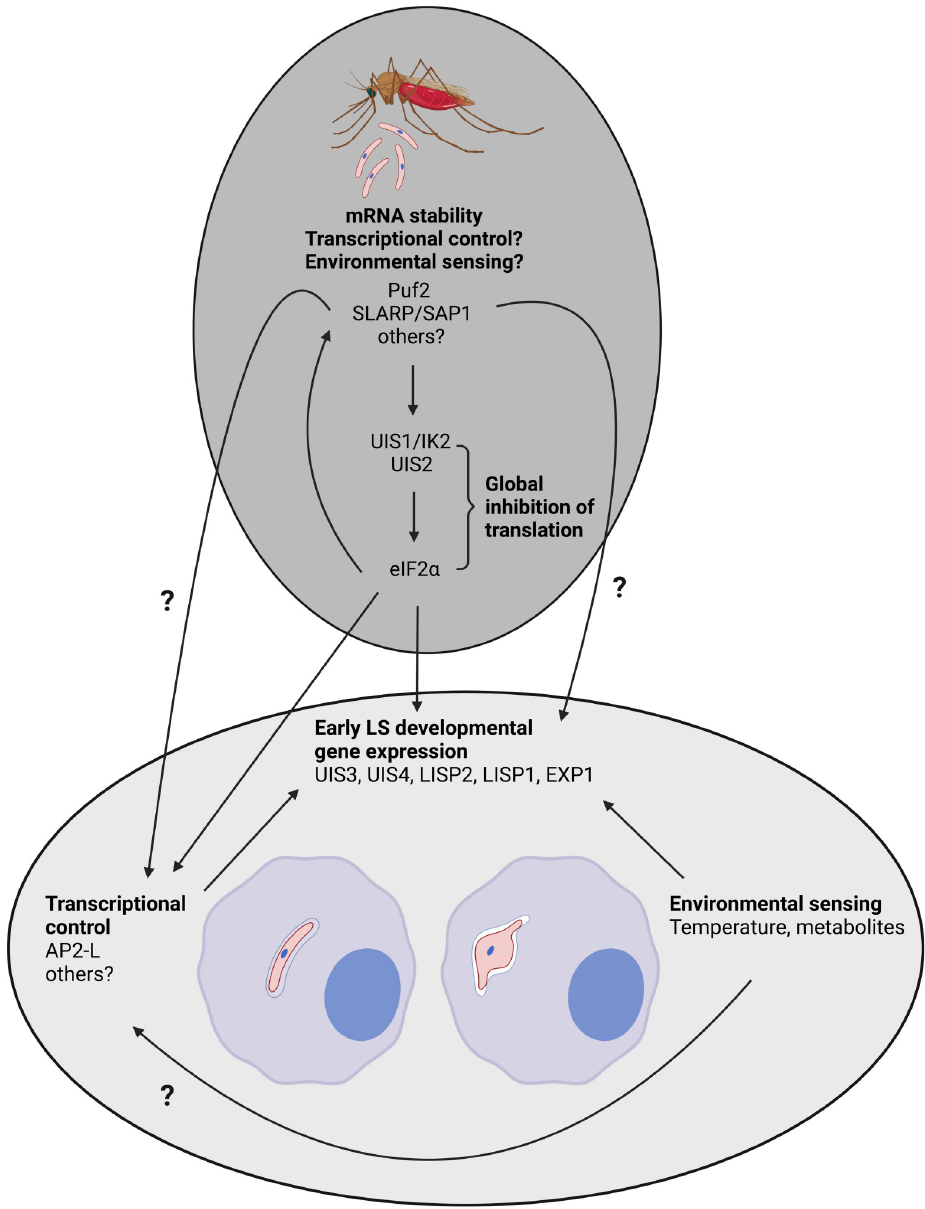
Fig 3. Parasite and host cell factors involved in sporozoite transformation into EEF represented as hierarchical events from mosquito to LS. The dark gray circle summarizes parasite factors currently known to exert posttranscriptional and translational control on sporozoites within mosquito salivary glands. The light gray circle summarizes parasite and host cell factors shown to have an effect on sporozoite transformation into EEF within the host hepatocyte. Arrows indicate the hierarchical events happening from sporozoite latency in the mosquito to the early LS developmental gene expression within hepatocyte. Question marks show a hypothetical role of factors acting directly on the sporozoite to EEF transition. References are listed in Table 1: pumilio-2 (Puf2), sporozoite and LS asparagine-rich protein/sporozoite asparagine-rich protein (SLARP/SAP1), up-regulated in infective sporozoites 1/ initiation factor 2 kinase (UIS1/IK2), up-regulated in infective sporozoites 2 (UIS2), eukaryotic translation initiation factor 2 subunit alpha (eIF2 α ), AP2 domain transcription factor (AP2-L), liver-specific protein 2 (LISP2) and here for up-regulated in infective sporozoite 3 (UIS3) [127], up-regulated in infective sporozoite 4 (UIS4) [67], and here for liver-specific protein 1 (LISP1) [128], exported protein 1 (EXP1) [129], temperature and metabolites [28–30] (created with BioRender.com). EEF, exoerythrocytic form; LS, liver